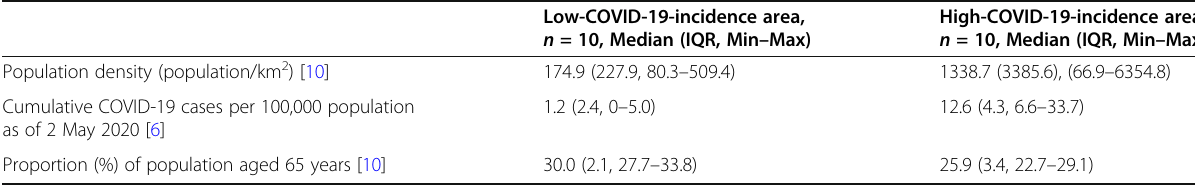
Table 1 Geographical and demographical characteristics of the study